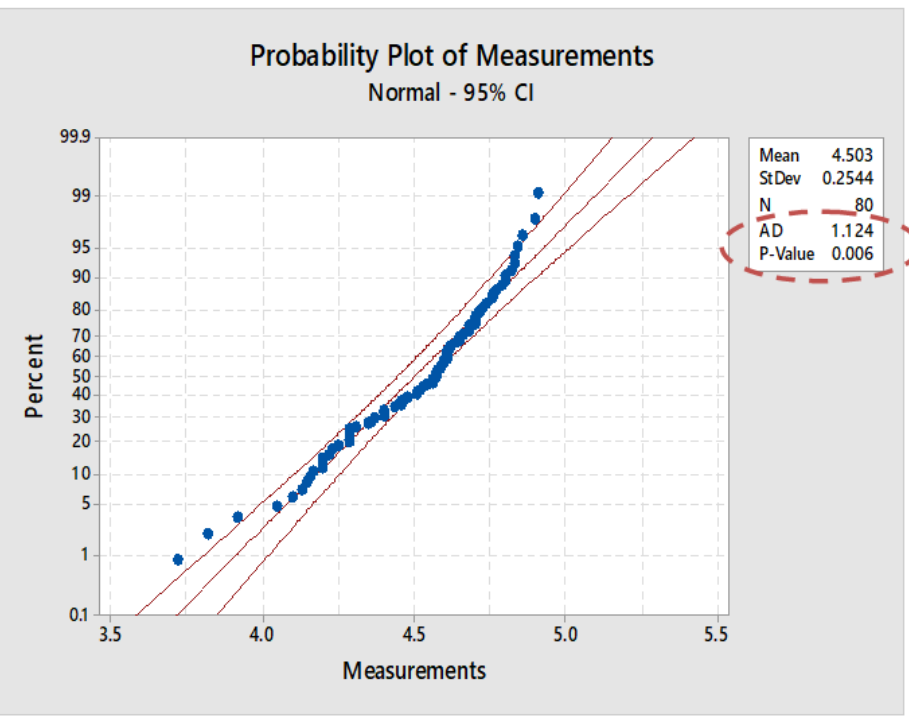
Figure 17. Probability diagram for the measurements taken.